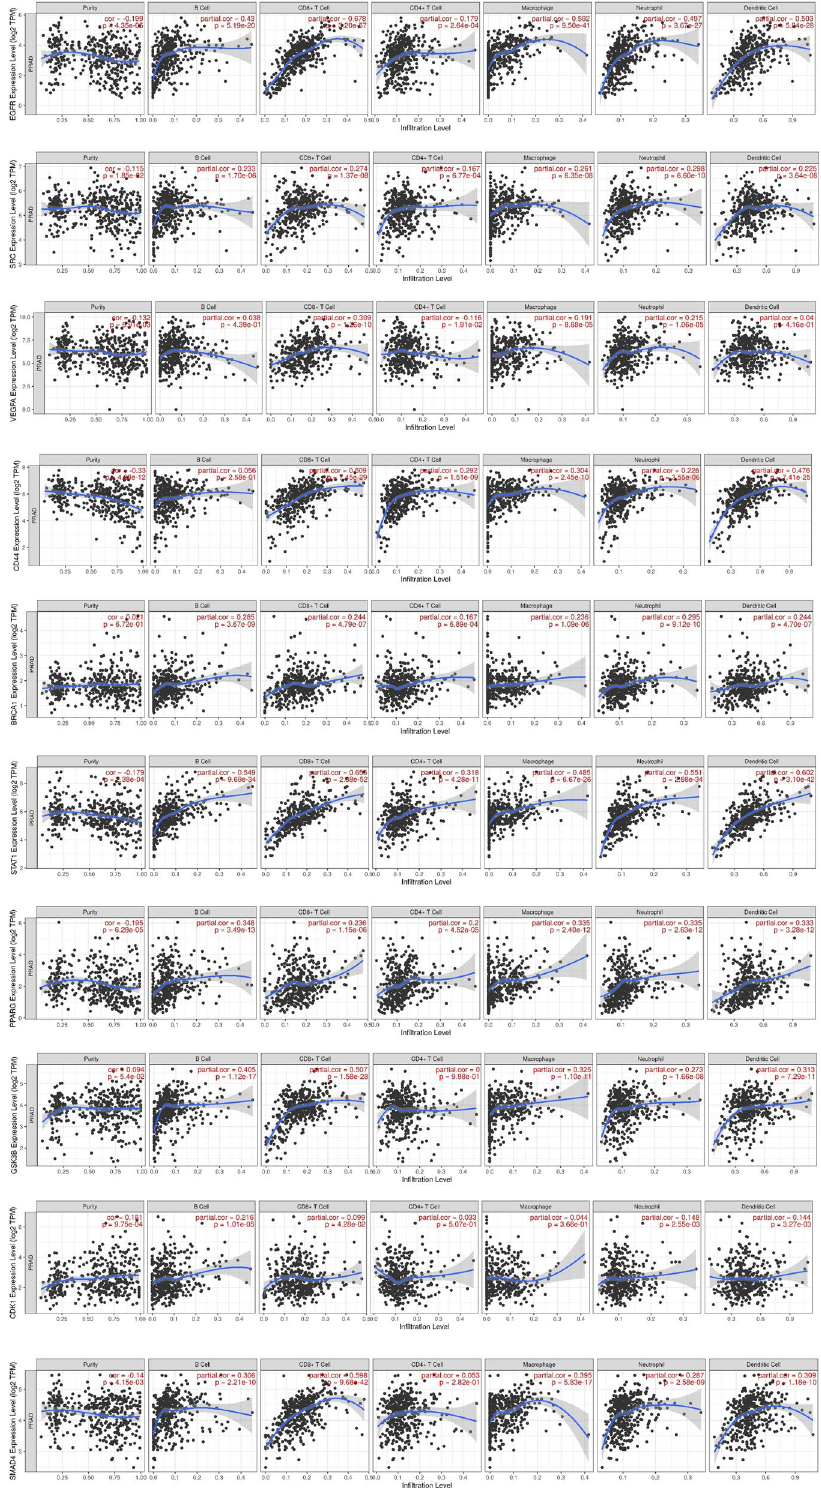
Fig. 8 The correlation between the expression levels of the hub genes and the infiltration levels of B cells, CD8 macrophages, neutrophils, and dendritic